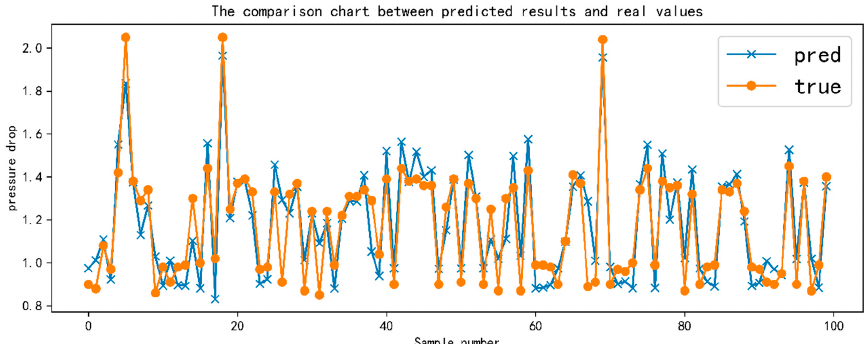
Figure 11. Prediction comparison chart of traditional BP pressure drop model.